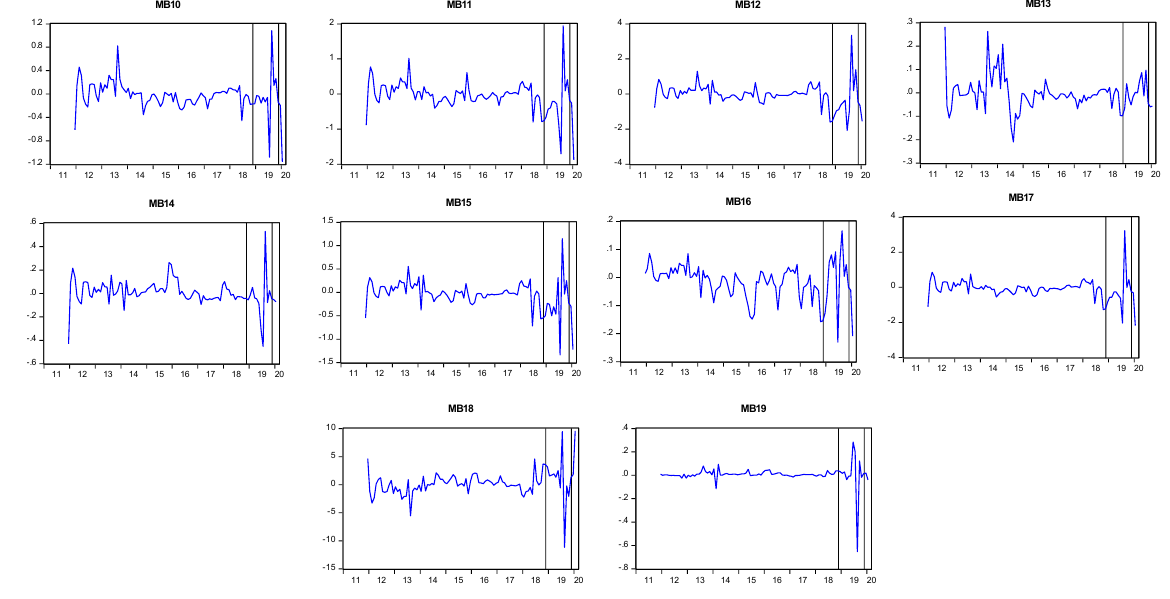
Figure A1 (cont.). Rolling regression estimates from Model